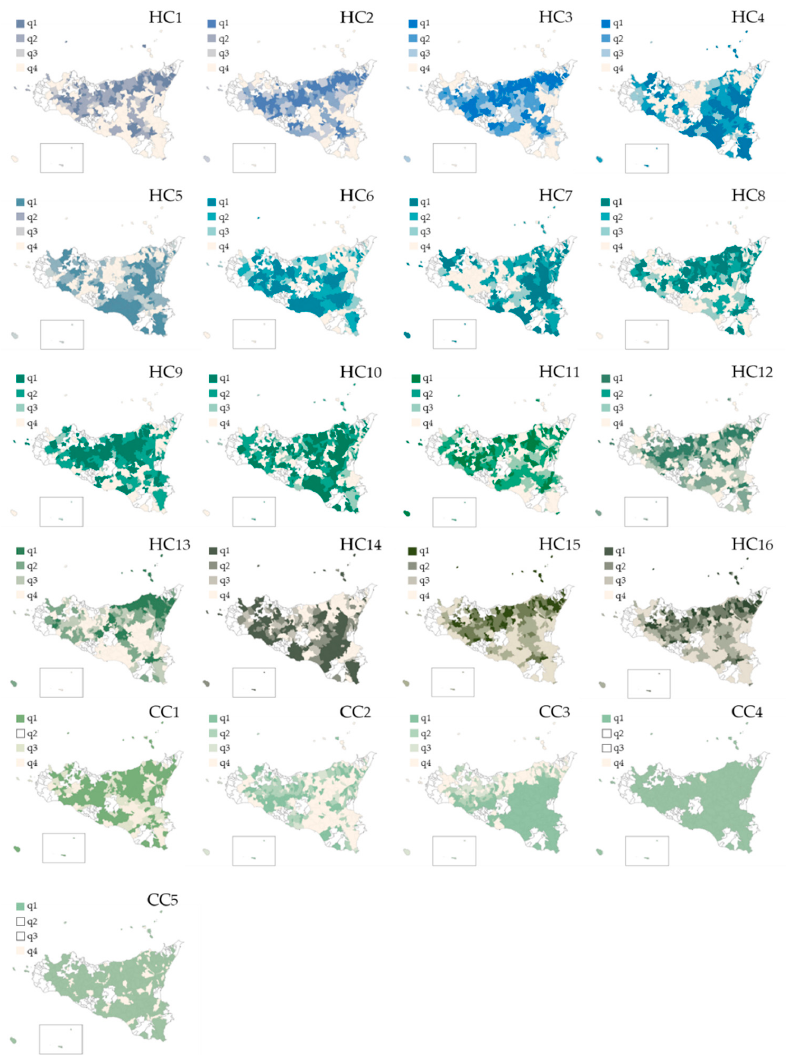
Figure 9. Mapping Human and Cultural Capital Indicators. (Authors’ elaboration.)